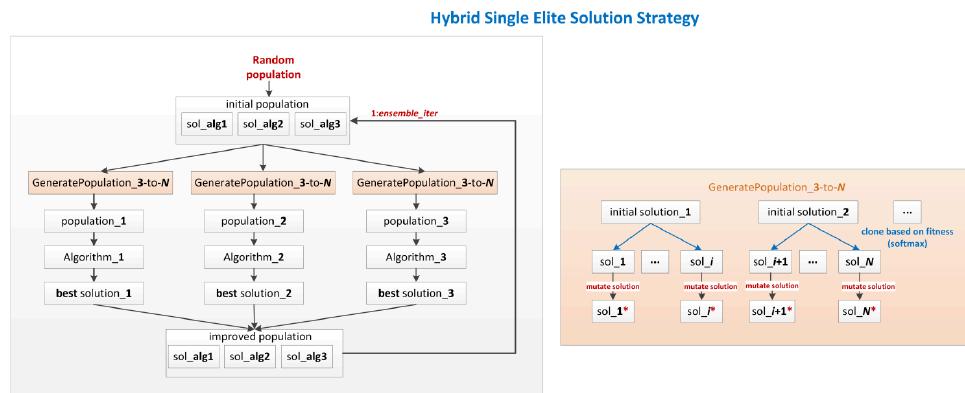
Figure 5. Hybrid single elite solution strategy. For each iteration of the ensemble, an initial population sol_i*, i=1..N, is generated by cloning the best solutions of each algorithm from the previous